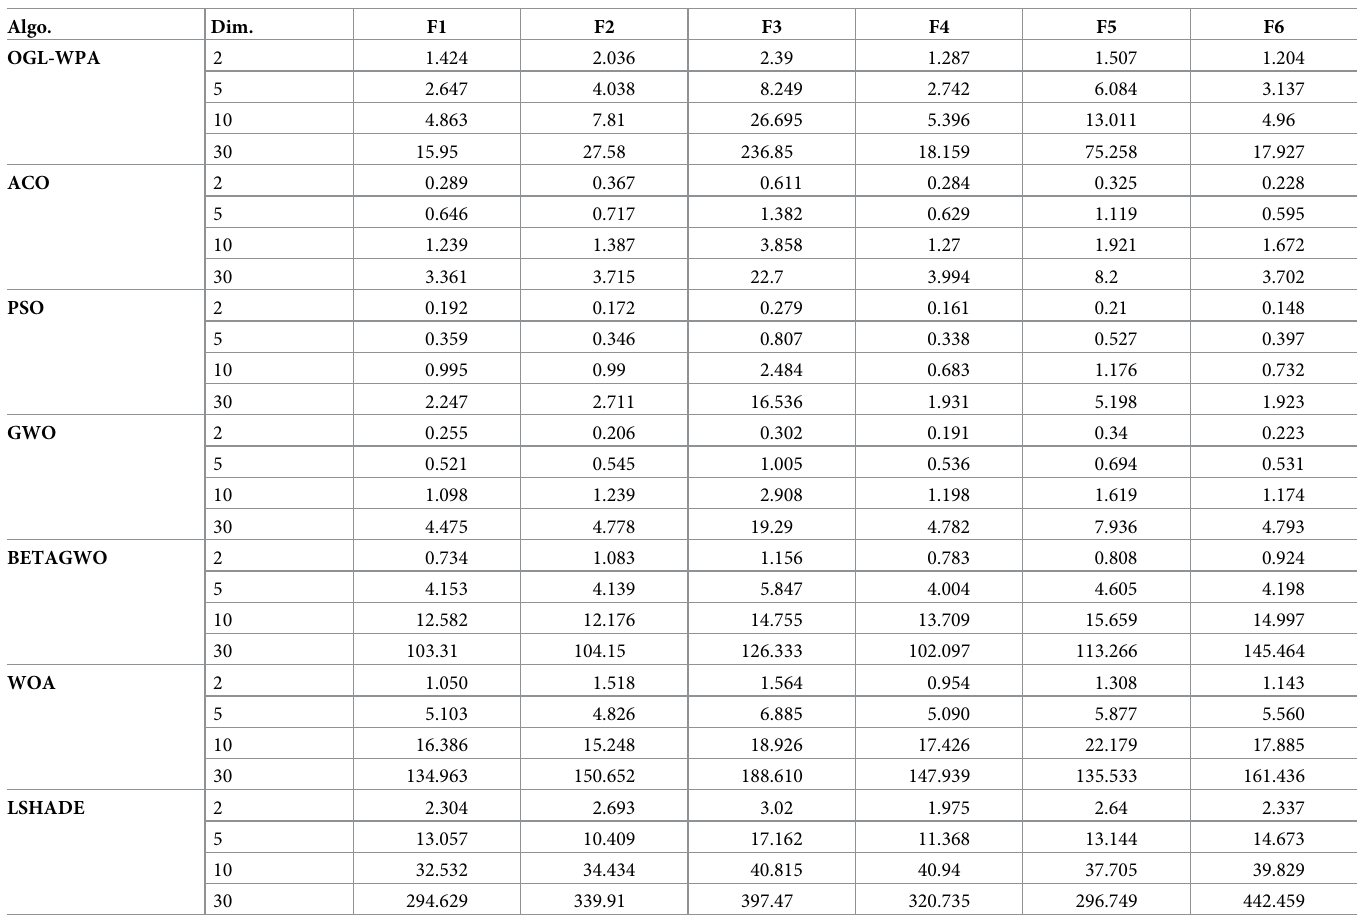
Table 3. Computational time of each algorithm—Part I. Algo.